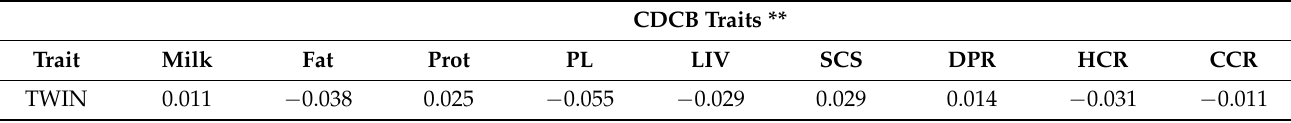
Table 6. Product-moment (Pearson) correlations between TWIN and CDCB traits ( n = 1,076,031). CDCB Traits **